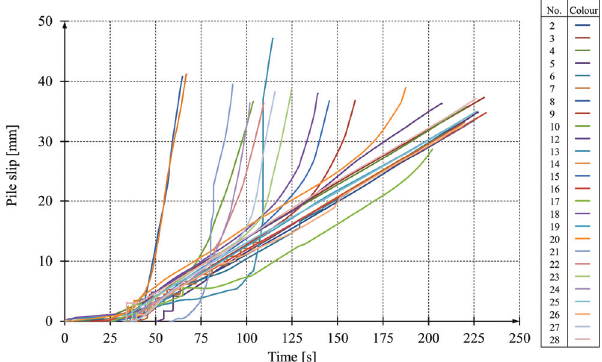
Photo 8. Form of brick specimens failure